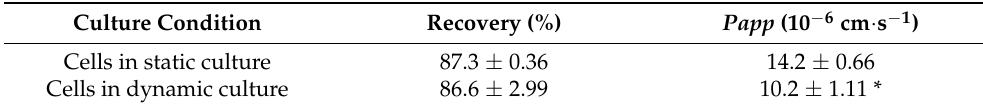
Table 2. Results from lucifer yellow (LY) permeability measurement in hCMEC/D3 cells maintained for seven days in our barrier device. Experiment was performed in duplicate on cells cultured in static or dynamic condition (under shear stress of 10 dyn · cm − 2 ). Results are given as means ± standard deviation. Recovery percentages estimated the loss of LY during the experiment due to LY non-specific binding. Apparent endothelial permeability ( Papp ) was calculated as previously described [18]. *: Student p -value <